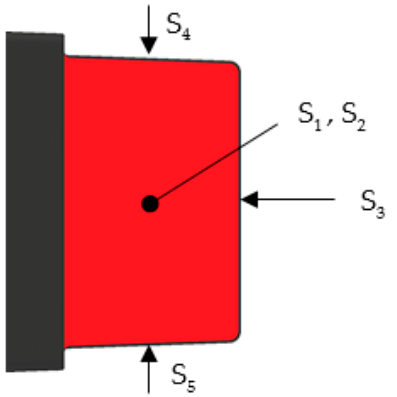
Figure 13. Partition of the fin surface used for the calculations of heat flow.